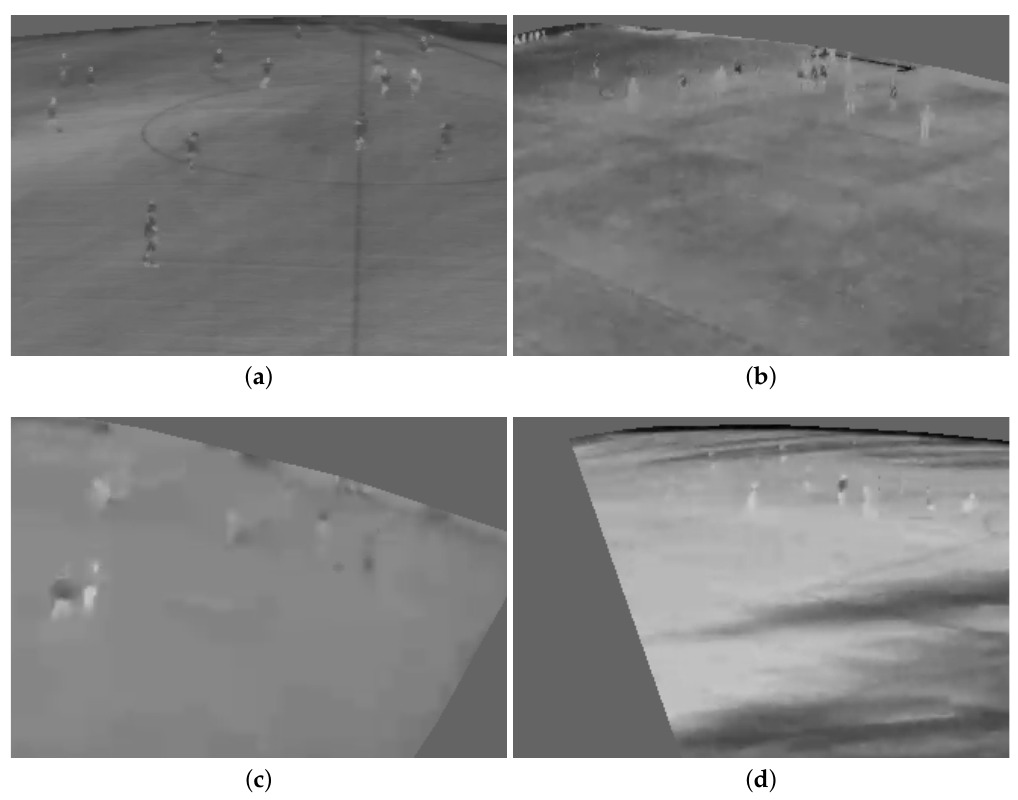
Figure 1. Some challenging characteristics in thermal data. ( a ) Varying body temperatures. ( b ) Similar temperatures. ( c ) Motion blur due to wind. ( d )